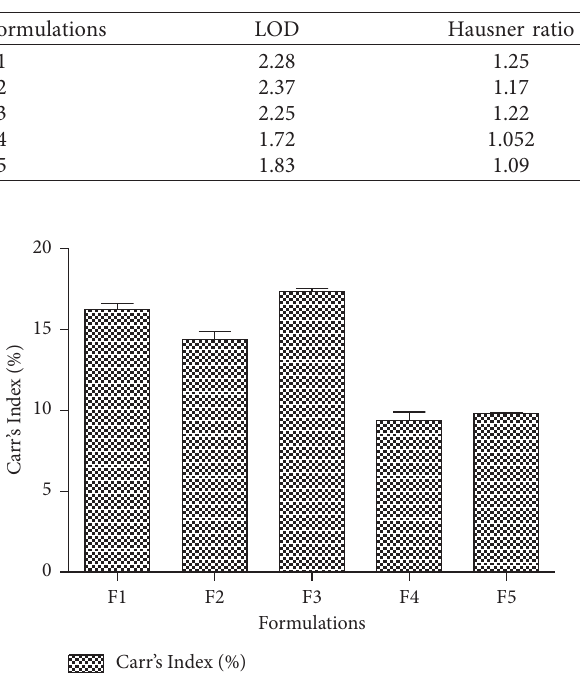
Figure 3: Carr’s index (%) of different formulation of SRP. Values are expressed as mean ± SD ( n �